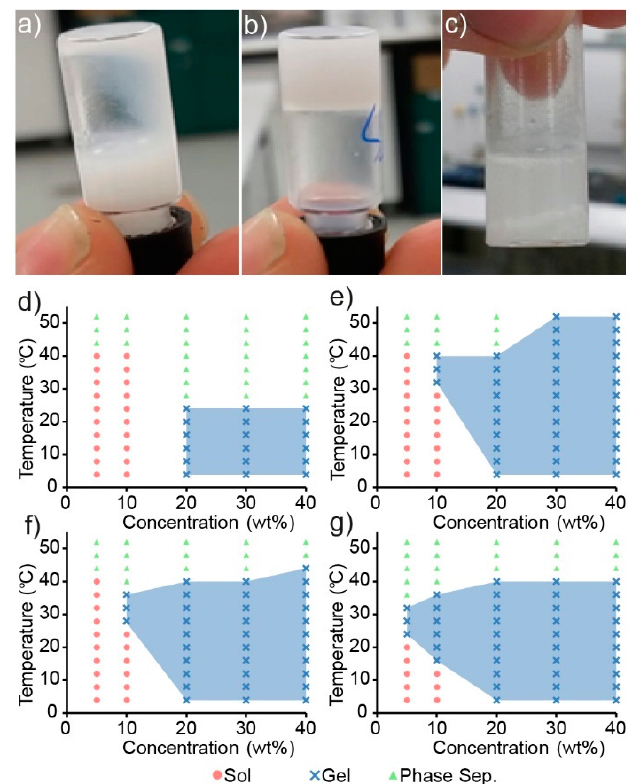
Figure 4. Digital images of PEG 1 PPG 3 when present in ( a ) solution (10 wt%, 4 ◦ C) and ( b ) gel (10 wt%, 37 ◦ C) states, and as a ( c ) phase separated mixture (10 wt%, 50 ◦ C). Sol–gel phase diagrams for ( d ) PEG 1 PPG 1 , ( e ) PEG 1 PPG 2 , ( f ) PEG 1 PPG 3 and ( g ) M 0.7 PEG 1 PPG 2 copolymers, with coloured symbols denoting the observed phase state of the solutions when inverted, and blue shaded areas denoting the observed gel regions.